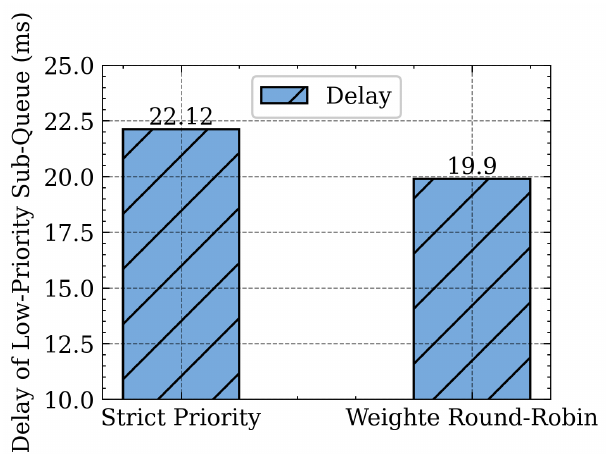
Figure 24. Influence of queue scheduling